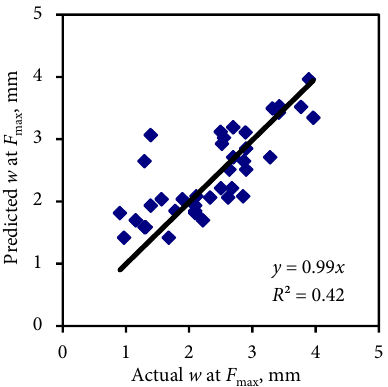
Fig. 5. Prediction of w at F max for independent query test dataset